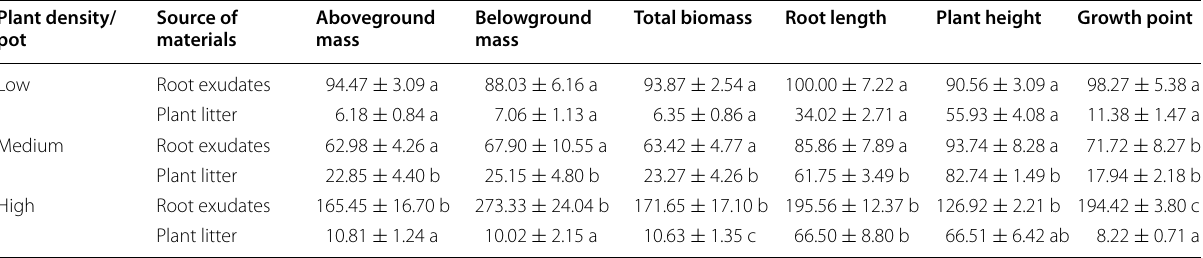
Average ( standard error) values in the column followed by same letter are not significantly different at the 0.05 level by Duncan’s ±